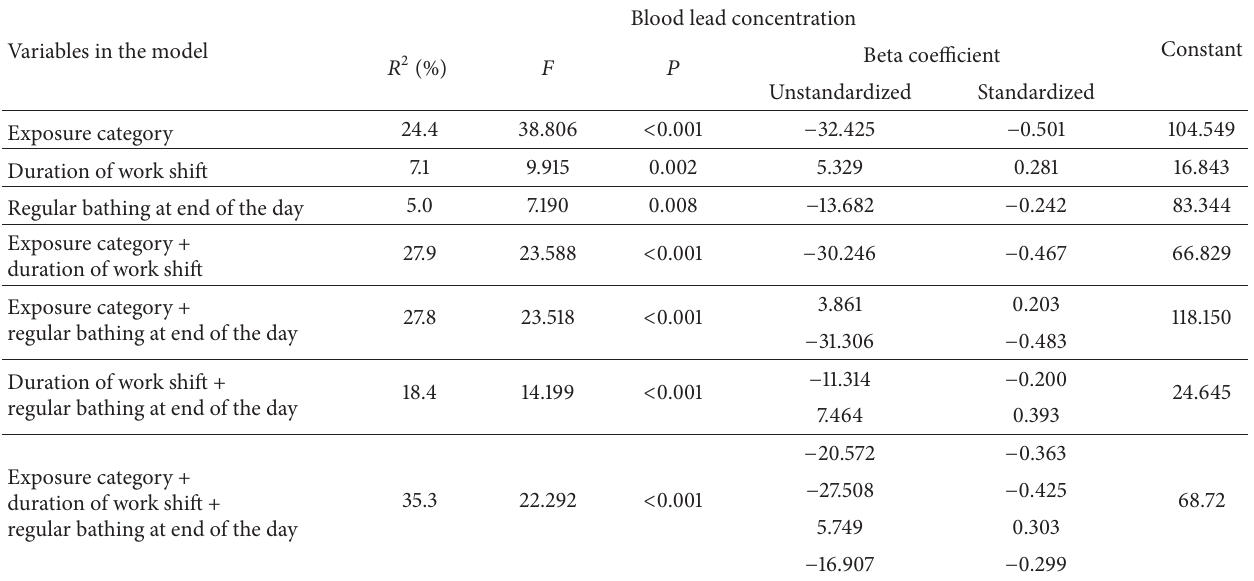
Table 6: Predictions of blood lead